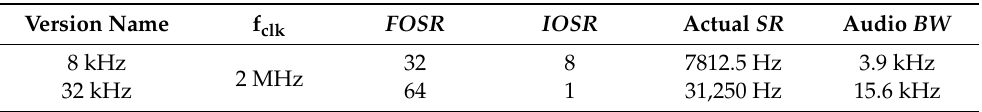
Table 1. Logger DFSDM configurations summary for both the high-quality (32 kHz) and extended autonomy (8 kHz) versions of the audio